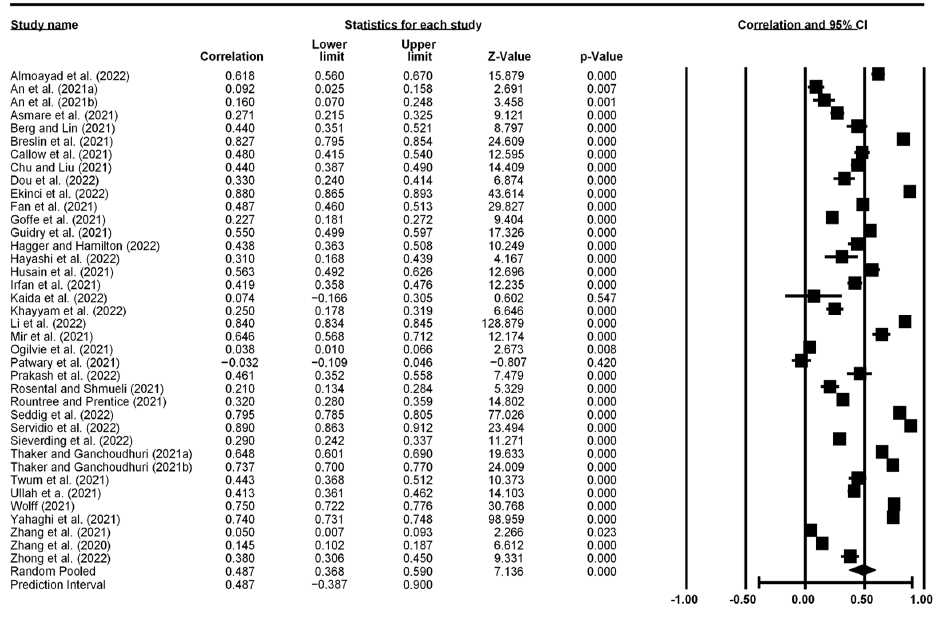
Figure 3. Forest plot showing subjective norms and vaccination intention correlation.